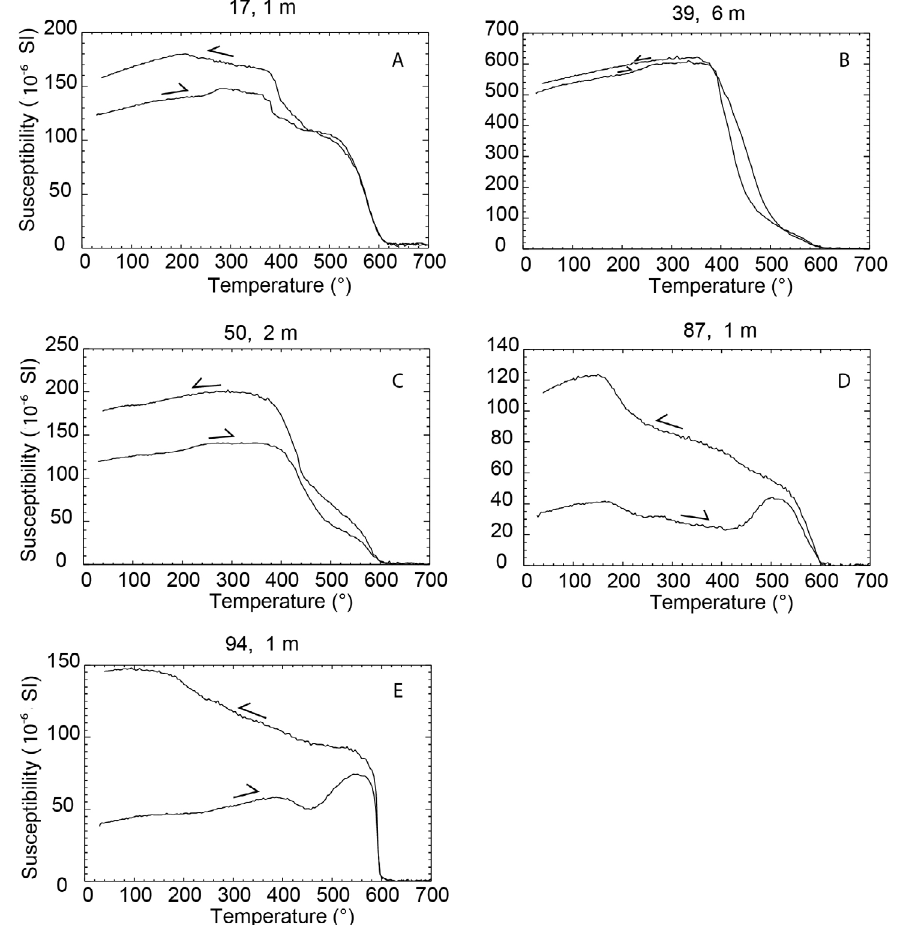
Figure 3. Thermomagnetic (A-E) curves for one representative specimen for each